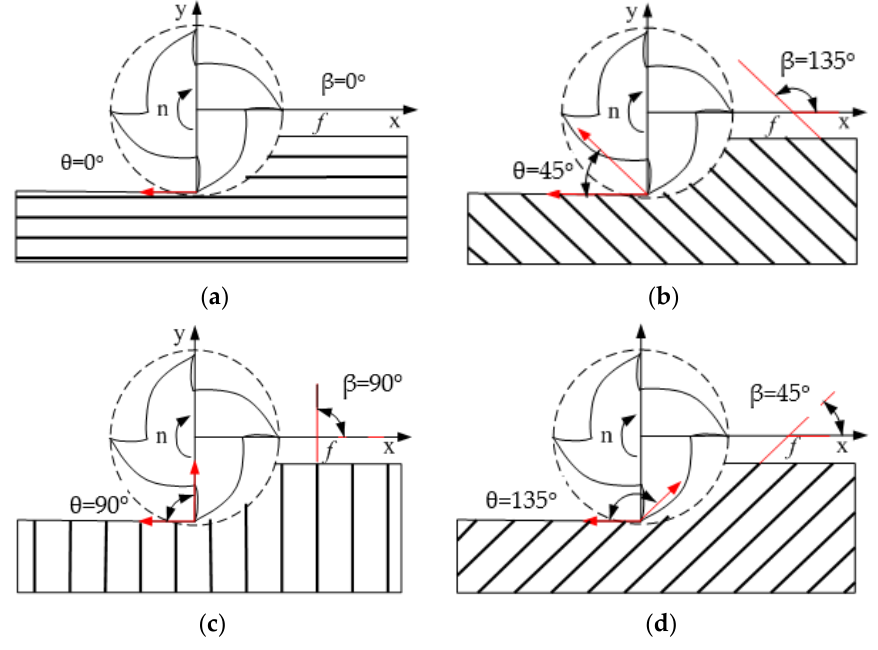
Figure 9. Fiber cutting direction in milling: ( a ) θ = 0° ; ( b ) θ = 45° ; ( c ) θ = 90° ; ( d ) θ = 135° .